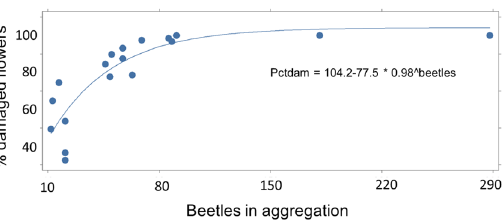
Figure 3. Non-linear regression fitted curve showing asymptotic relationship between number of Japanese beetles in natural aggregations on A . syriaca umbels and percentage of flowers already damaged. At the time of collection, aggregations of 40 or more JB had destroyed 75–100% of the individual